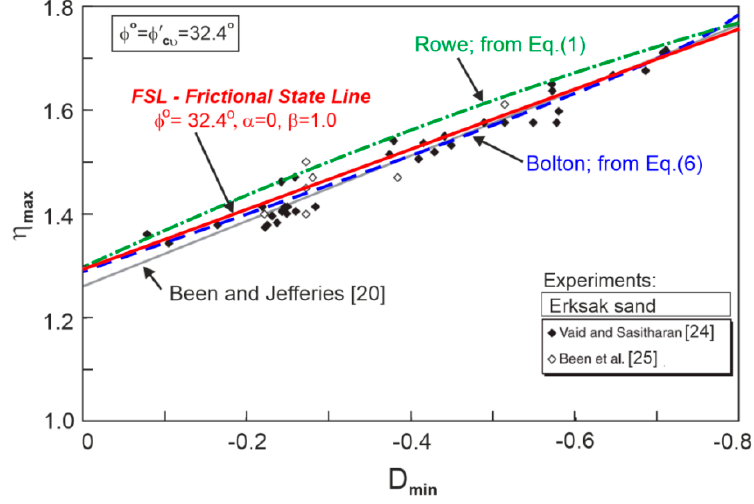
Figure 7. The relationships between the stress ratio and dilatancy at failure for Erksak sand (adapted from [24]).